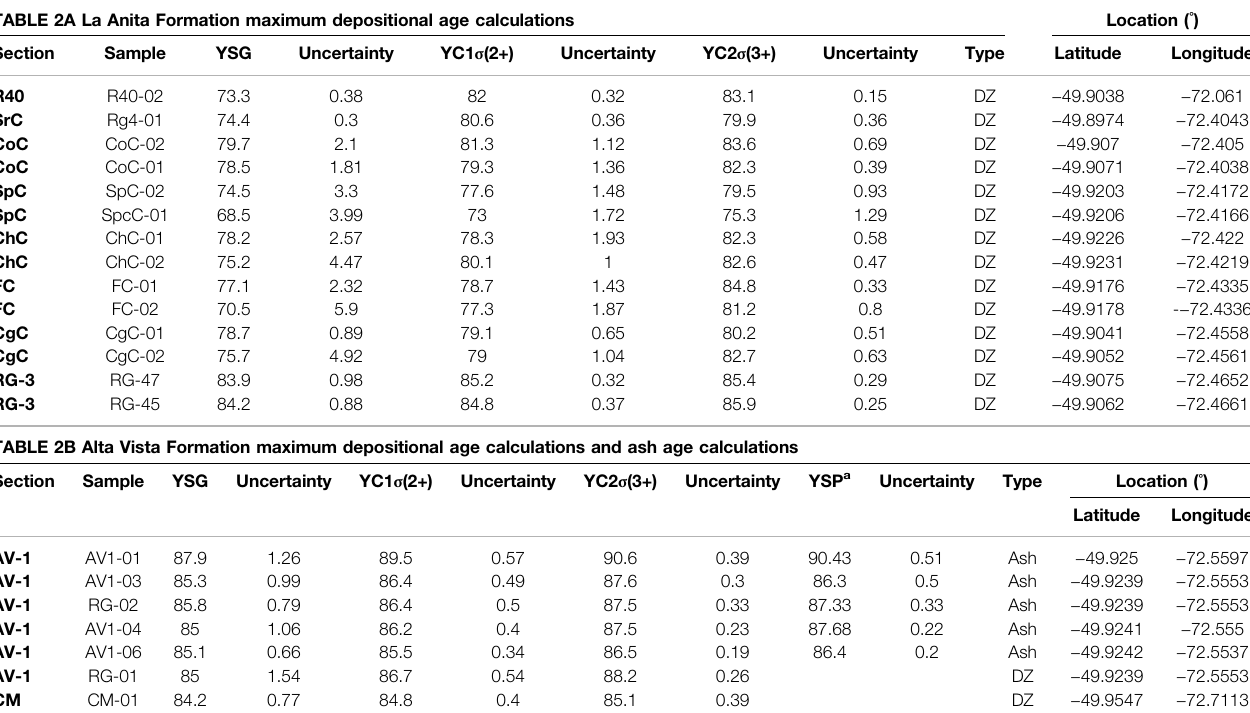
TABLE 2 | List of maximum depositional ages and ash ages from the Alta Vista and La Anita Formations. TABLE 2A La Anita Formation maximum depositional age calculations Location ( ° )